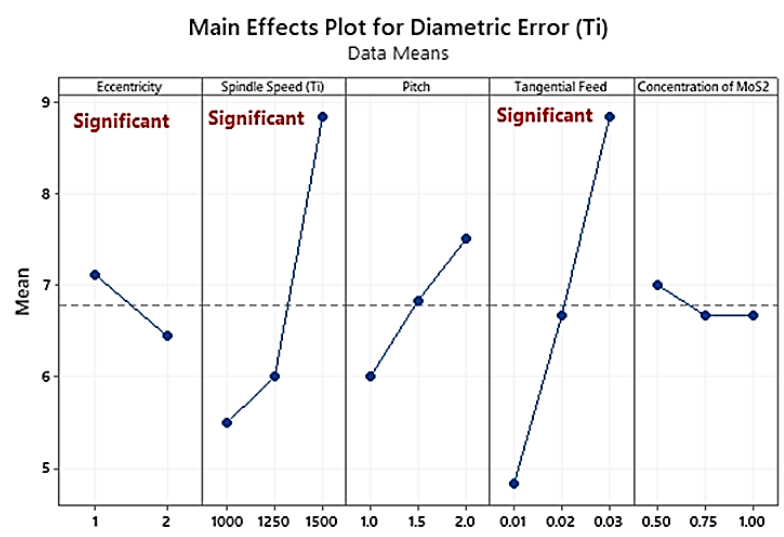
Figure 5. Main effects plot of diametric error in Ti6Al4V hole-making. Table 4. Analysis of variance of the diametric error of Ti6Al4V.